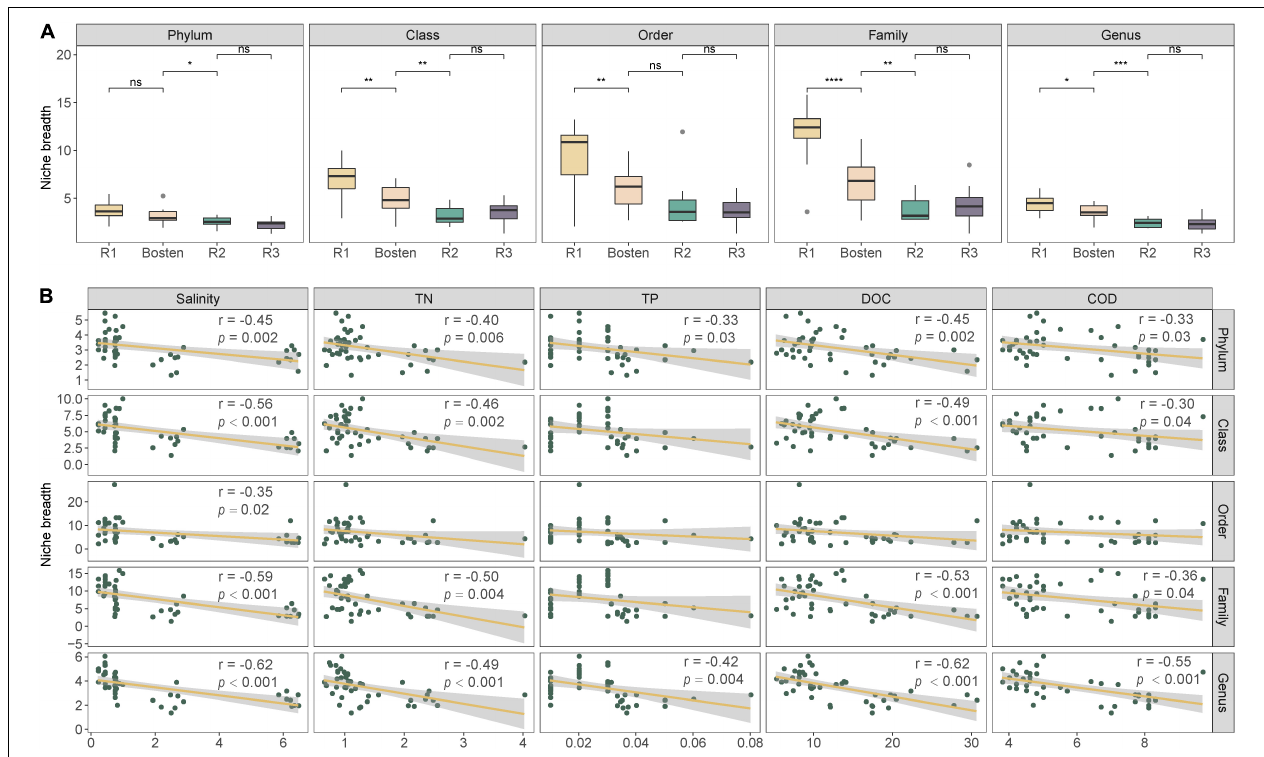
FIGURE 7 | The niche breadth of bacterial communities among the four lakes (A) and their relationships with environmental parameters (B) . Significance levels: ns: p -value > 0.05; * p -value < 0.05; ** p -value < 0.01; *** p -value <